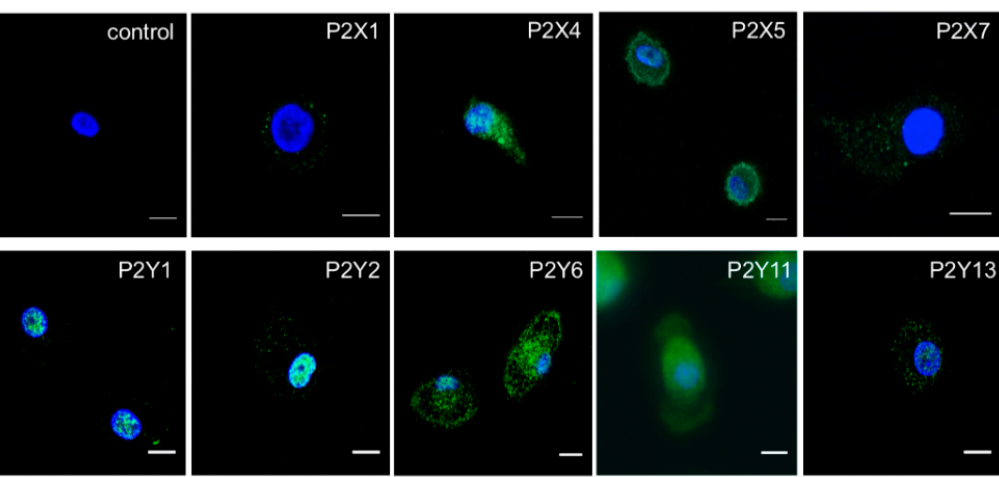
Figure 4. Immunocytochemistry of P2Y and P2X receptor expression in M-CSF differentiated human macrophage. Dual fluorescence images showing staining arising from the use of primary antibodies against receptor subtypes in green and nucleus counterstain in blue (DAPI). Control is representative of experiments performed in the absence of primary antibodies. Images representative of experiments performed on macrophage isolated from three independent donors. Scale bar is 10 μ m.